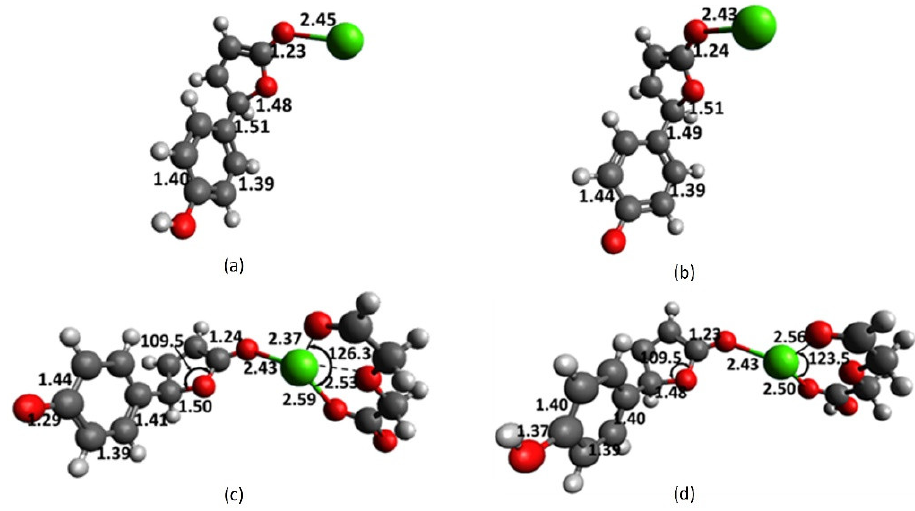
Figure 6. Optimized geometries of complexes with 5 and 5a in methanol; ( a ) complex of 5 and Ca 2+ , 2+ , ( c ) 5a - 4a -Ca 2+ complex, and ( d ) 5 - 4 -Ca 2+ ( b ) complex of 5a and Ca 2+ , ( c ) 5a - 4a -Ca 2+ complex, and ( d ) 5 - 4 -Ca 2+ complex. ( b ) complex of 5a and Ca